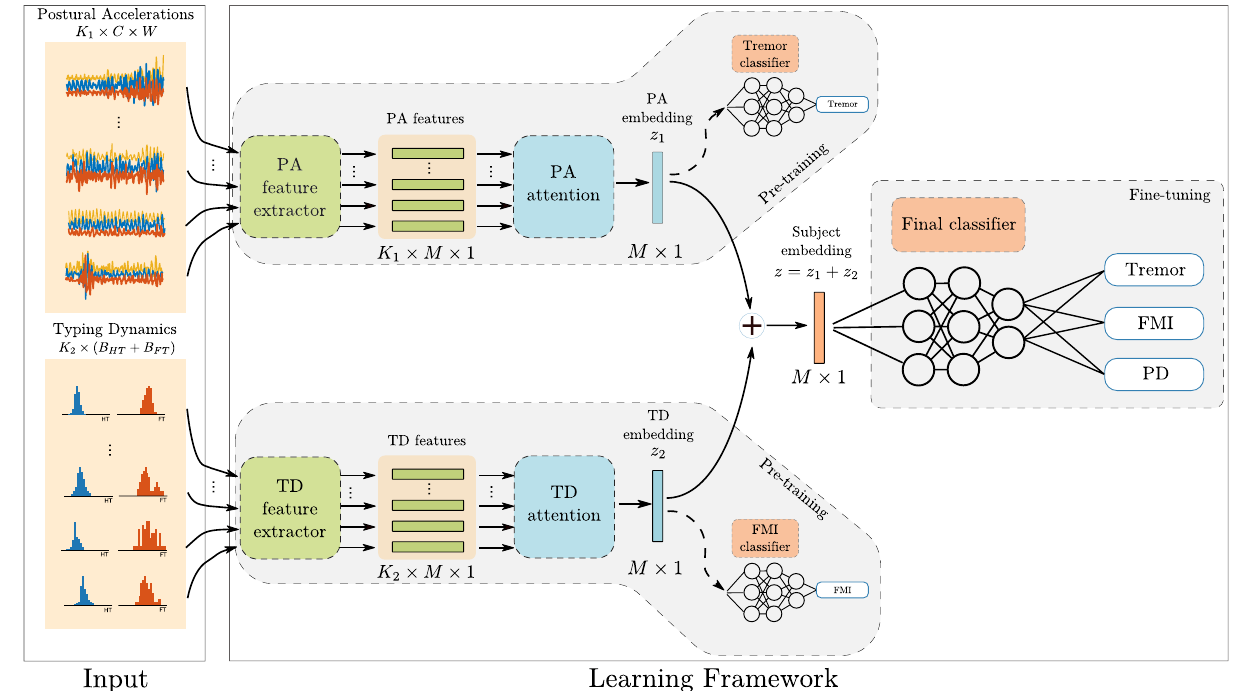
Figure 1. High-level overview of the deep learning system. Both input streams, represented by the Postural Accelerations (PA) and Typing Dynamics (TD) bags, consist of multiple data recordings ( K 1 and K 2 , respectively) that are transformed independently using a feature extraction module. The resulting M -dimensional features are used to produce a fixed-length embedding (also M -dimensional) using an attention- pooling module. The embeddings for each modality are fused together via a sum operation to produce the subject embedding, which is then used as input to a multi-label classifier module that outputs the probability of tremor, fine-motor impairment (FMI) and PD. Initially, the feature extractors and attention modules of the two modalities are separately pre-trained against the respective symptom ground-truth (tremor or FMI), using a temporary single-output classifier module. After pre-training, the initial classifier modules are discarded, the feature extraction and attention modules are frozen, the embedding vectors are joined and a new multi-output final classifier module is introduced and is fine-tuned using a multi-label logistic loss function (Eq. 4). C denotes the number of accelerometer channels, W the length in samples of each segment in the PA bag and B HT , B FT the number of bins for the hold and flight time histograms. Values for all parameters are given in Methods. Figure was drawn using Inkscape v1.0 https ://inksc